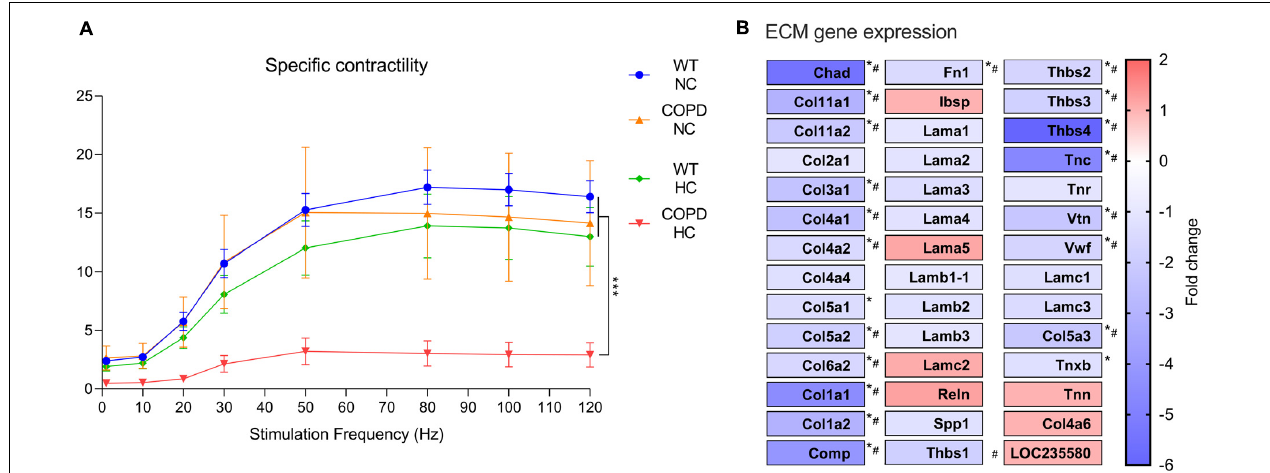
FIGURE 2 | The combination of COPD and hypercapnia leads to a reduced specific force generation capacity. (A) While normo and hypercapnia per se , and normocapnic (NC) murine COPD associate with a preserved specific force-generation capacity, the combination of murine COPD and hypercapnia (HC) leads to a significant reduction of specific force, which is a surrogate of intrinsic contractile properties of individual fibers ( n = 4), *** p < 0.001. (B) RNA seq analysis of EDL muscles obtained from normo and hypercapnic murine COPD model demonstrate a significant hypercapnia-induced downregulation of extracellular matrix (ECM) receptor interactions term and multiple genes. Sequencing was generated by an Ion Torrent Ion S5 plus system, Thermo Fisher scientific ( n = 4), * p < 0.05; # p > 1.5-fold change. For details about the animals details including genetic backgrounds and hypercapnia setup, see our recent publications (Jaitovich et al., 2015; Balnis et al., 2020a,b,c; Korponay et al., 2020). Presented data is original and thus has not been previously